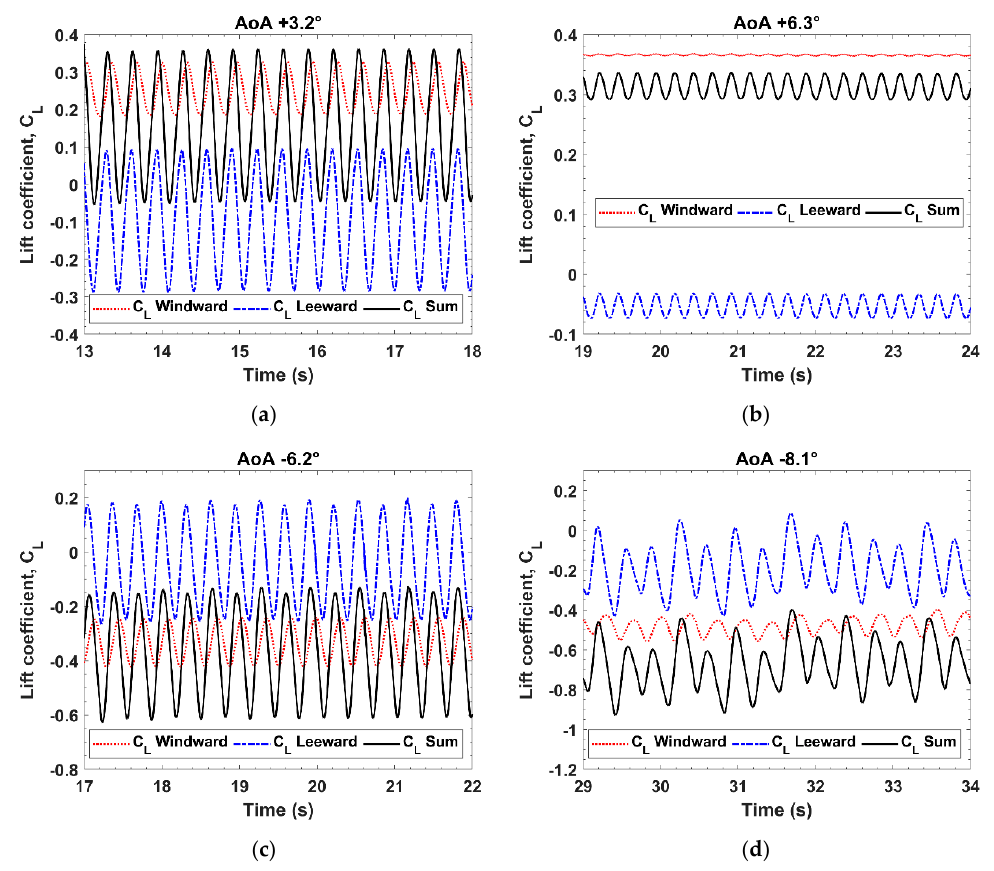
Figure 10. Time history of lift coefficient for different angles of attack: ( a ) AoA = +3.2°, ( b ) AoA = +6.3°, ( c ) AoA = − 6.2° and (d) AoA = − 8.1°.